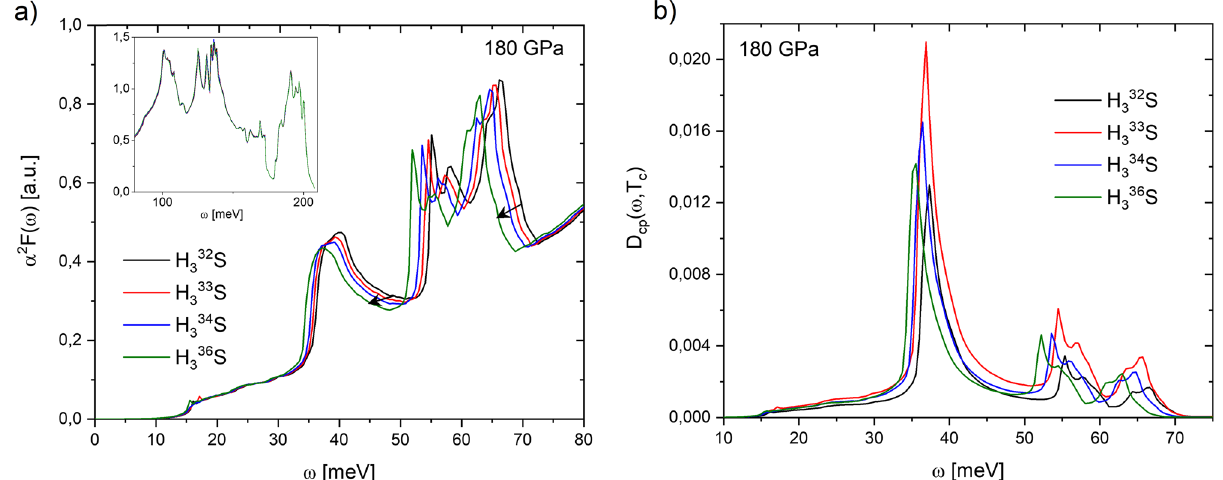
Figure 4. ( a ) Eliashberg spectral α 2 F (ω) and ( b ) D cp (ω , T c ) functions of H 32 3 S , H 33 3 S , H 34 3 S and H 36 3 S calculated at 180 GPa (arrows show as Eliashberg function smooths as isotope mass increases). The inset in ( a ) presents the α 2 F (ω) function from 80 to 220 meV. Note only changes in α 2 F (ω) are observed in the energy range of 10–70 meV. H n 3